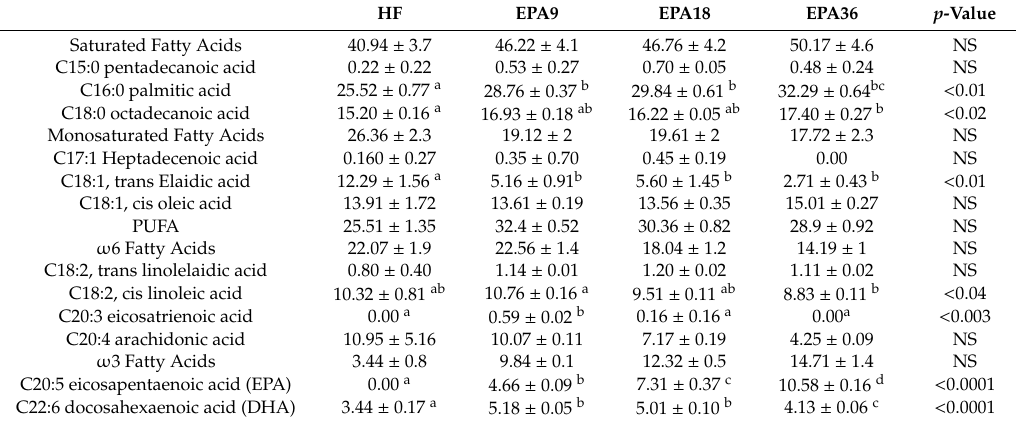
Table 2. Fatty acid composition of RBC in C57BL / 6J mice in the HF, EPA9, 18, and 36 groups